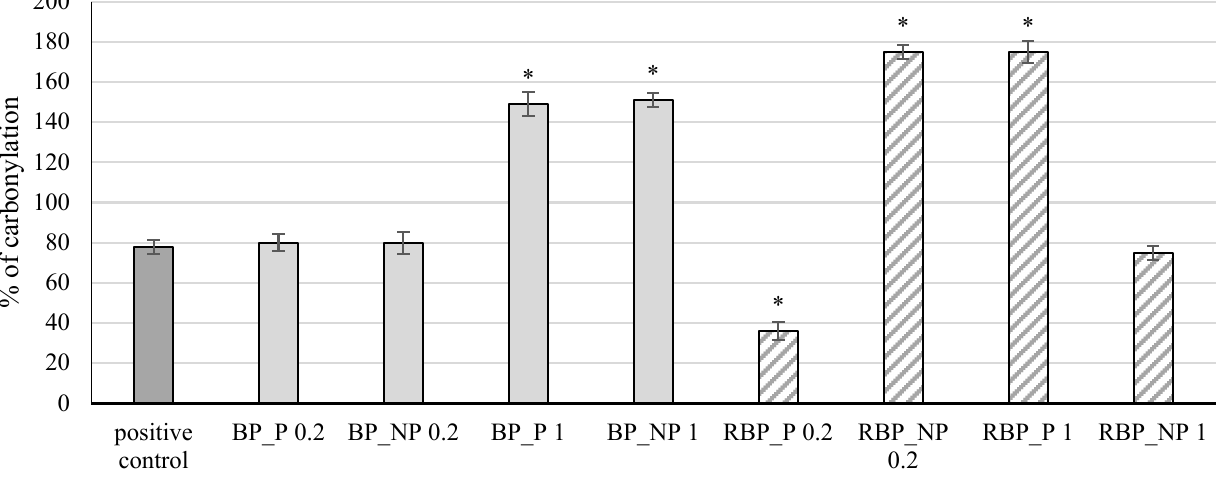
Figure 5. Effect of banana and red beetroot peel extracts on protein carbonylation. Results are presented as the mean value +/ − standard deviation of 3 independent experiments. BP_P ‐ banana peel extract with polysaccharides; BP_NP ‐ banana peel extract without polysaccharides; RBP_P ‐ red beetroot peel extract with polysaccharides; RBP_NP ‐ red beetroot peel extract without polysaccharides, concentrations 0.2 and 1 mg mL − 1 ; *—statistically significant ( p < 0.05) difference in comparison to positive control.